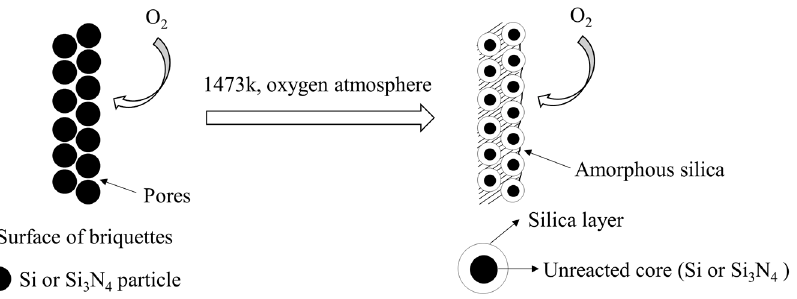
Figure 7. Formation of SiO 2 layer on the surface of briquettes after heating under an oxygen atmos- phere.